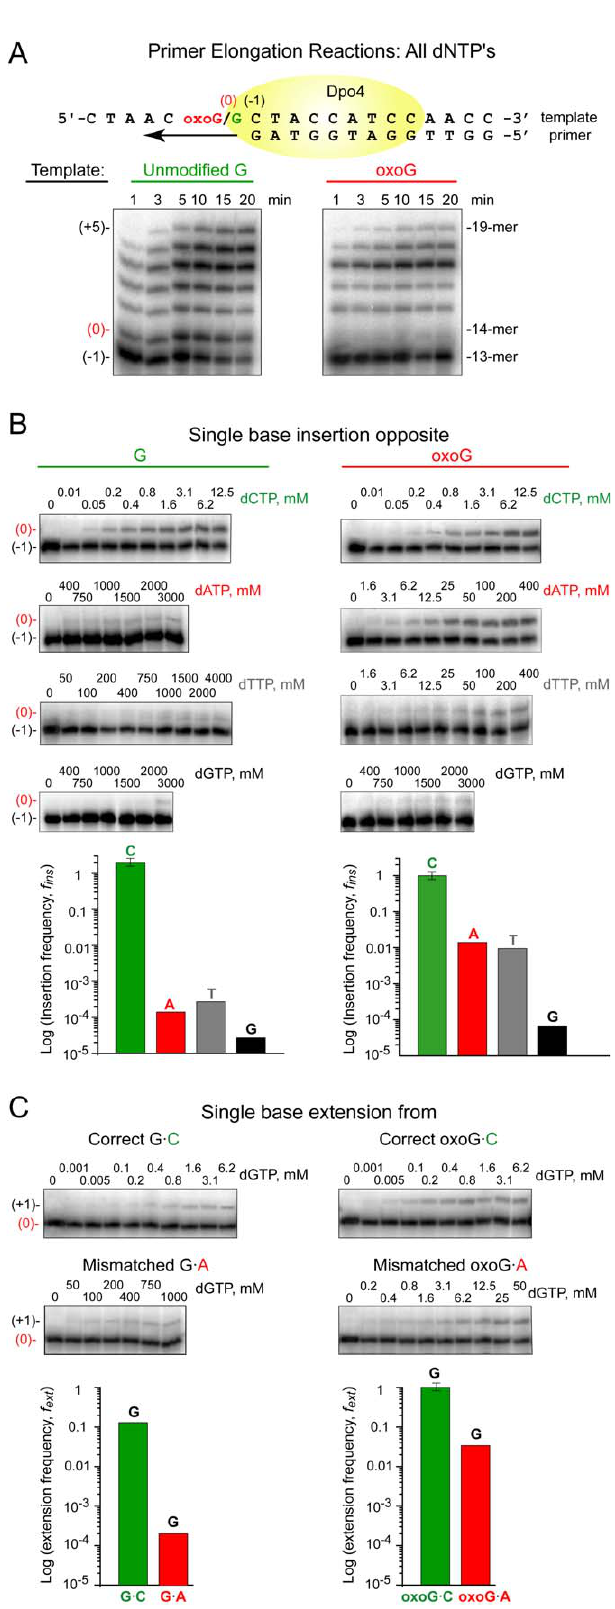
Figure 1. Fidelity and Efficiency of Base Incorporation on Unmodified G and oxoG-Modified Templates by Dpo4 (A) Time course of 32 P 5 9 -end-labeled 13-mer primer extension on 19-mer G (left panel) or oxoG (right panel) templates in the presence of all